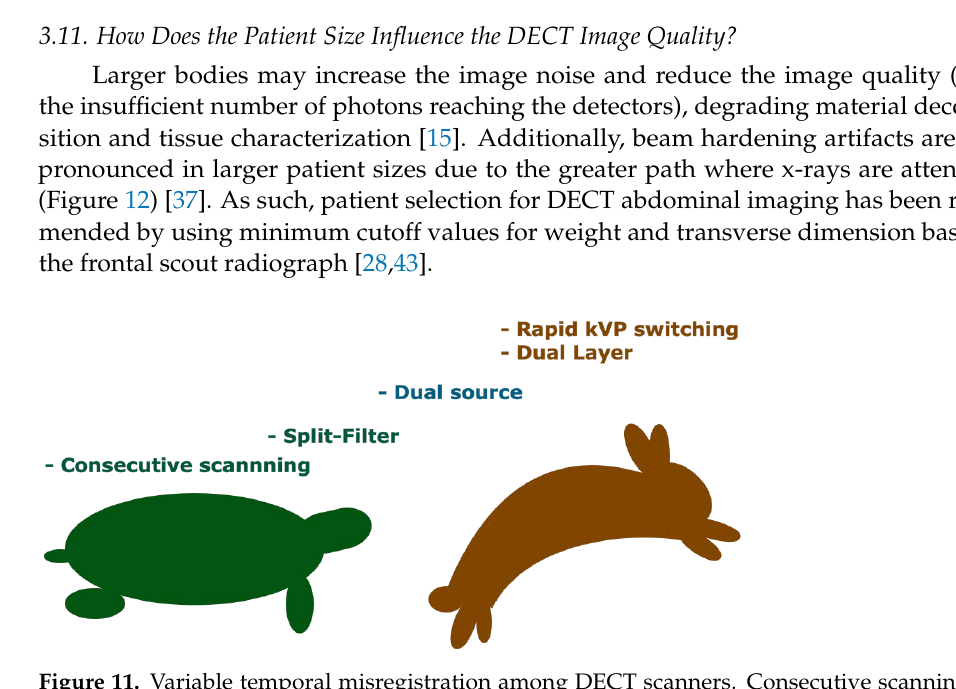
Figure 11. Variable temporal misregistration among DECT scanners. Consecutive scanning tech- niques are more prone to temporal misregistration and motion. Split-filter DECT scanners require an entire spiral acquisition, so the pitch values are low, resulting in relatively poor temporal registration. Although dual-source DECT scanners have an orthogonal offset of the 2 source-detector pairs induc- ing spectral delay, its tube design largely improves the temporal resolution. Temporal misregistration is negligible with rapid kVp switching and dual-layer DECT scanners.